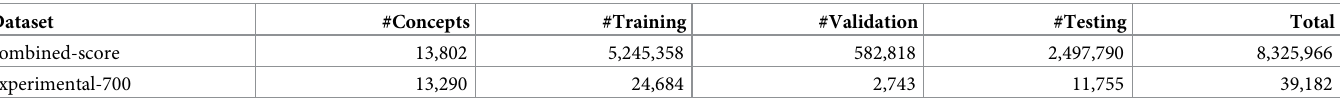
Table 4. Statistics of the datasets for PPI prediction. #Concepts: the number of concepts in the dataset. #Training: the number of training instances; same applies to #Validation and #Testing.